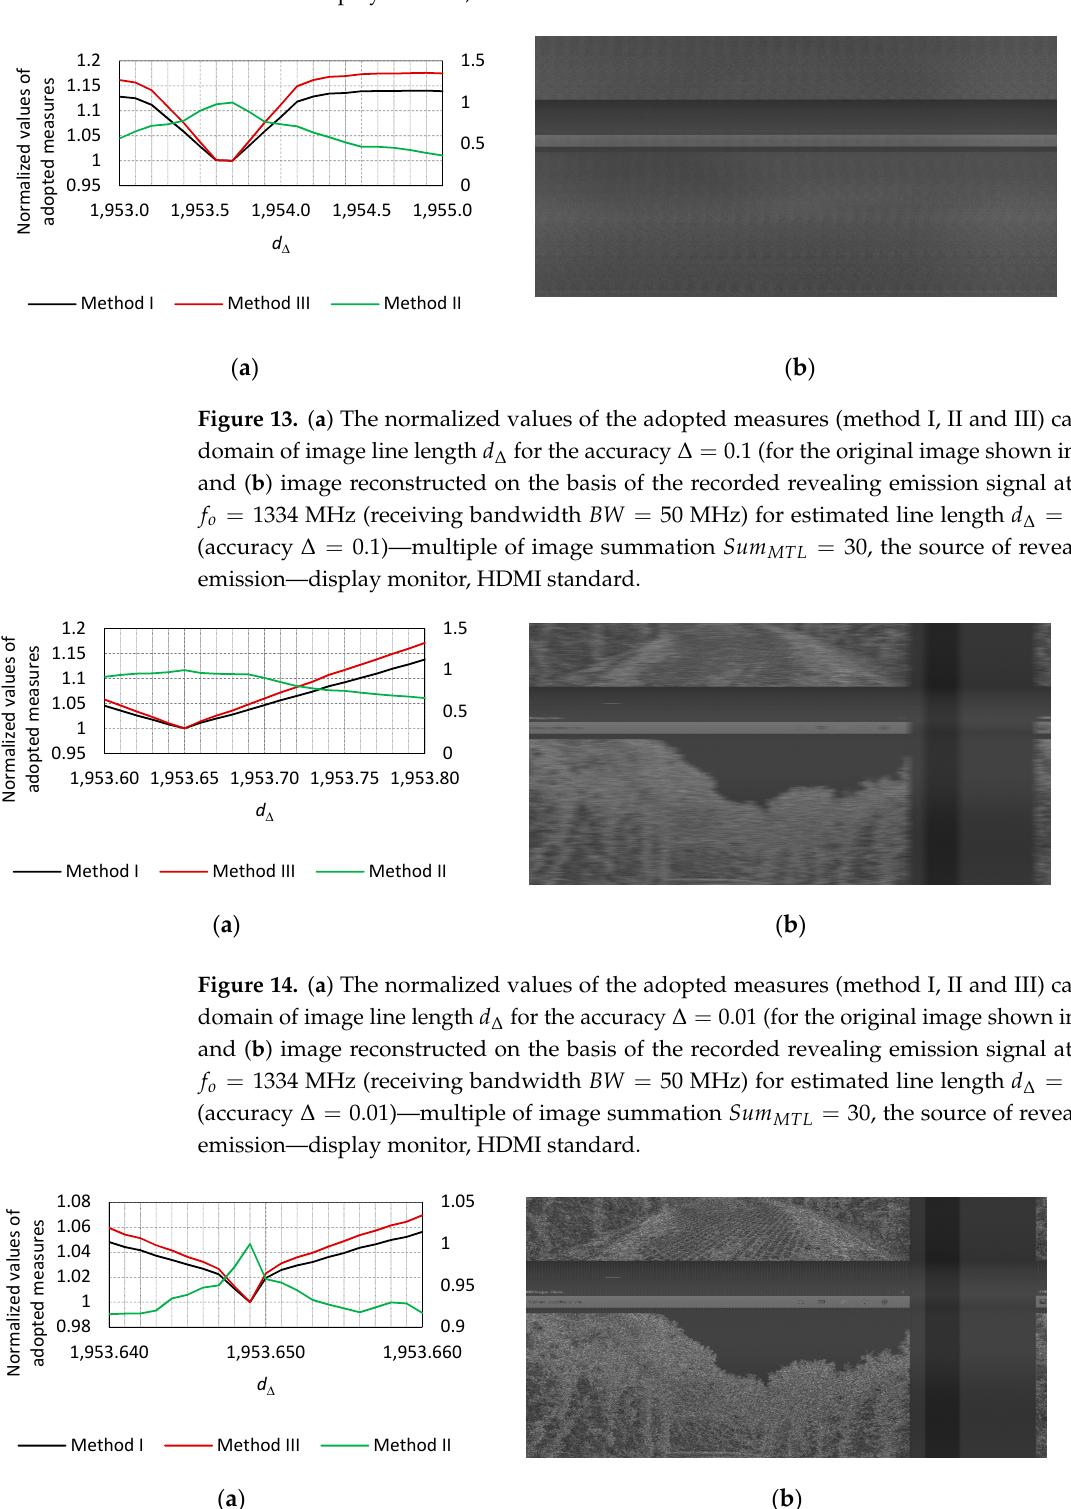
d ∆ = 1954.00000, multiple of image summation Sum MTL = 1 and ( c ) for estimated line length d ∆ = 1954.00000, image summation multiple Sum MTL = 30 —the source of revealing signal emission—display monitor, HDMI standard.